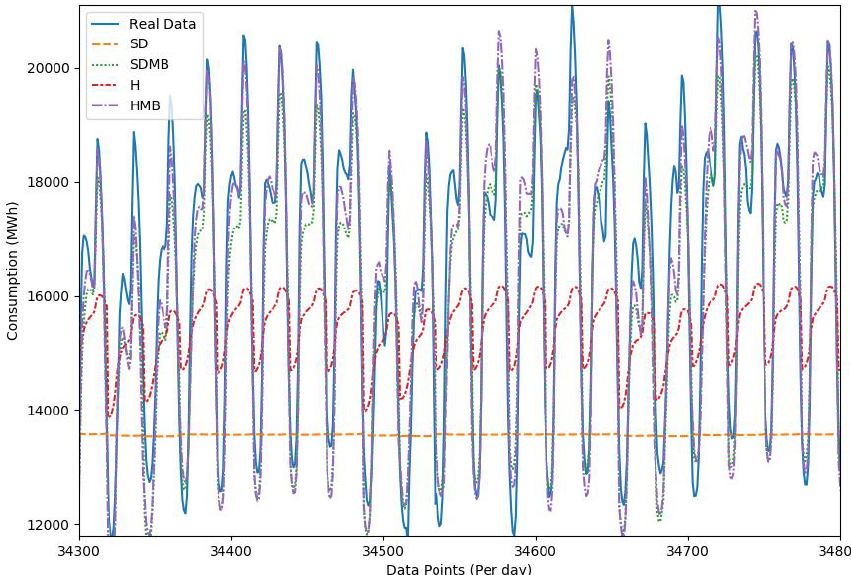
Figure 4. The neural network with the algorithms during training.